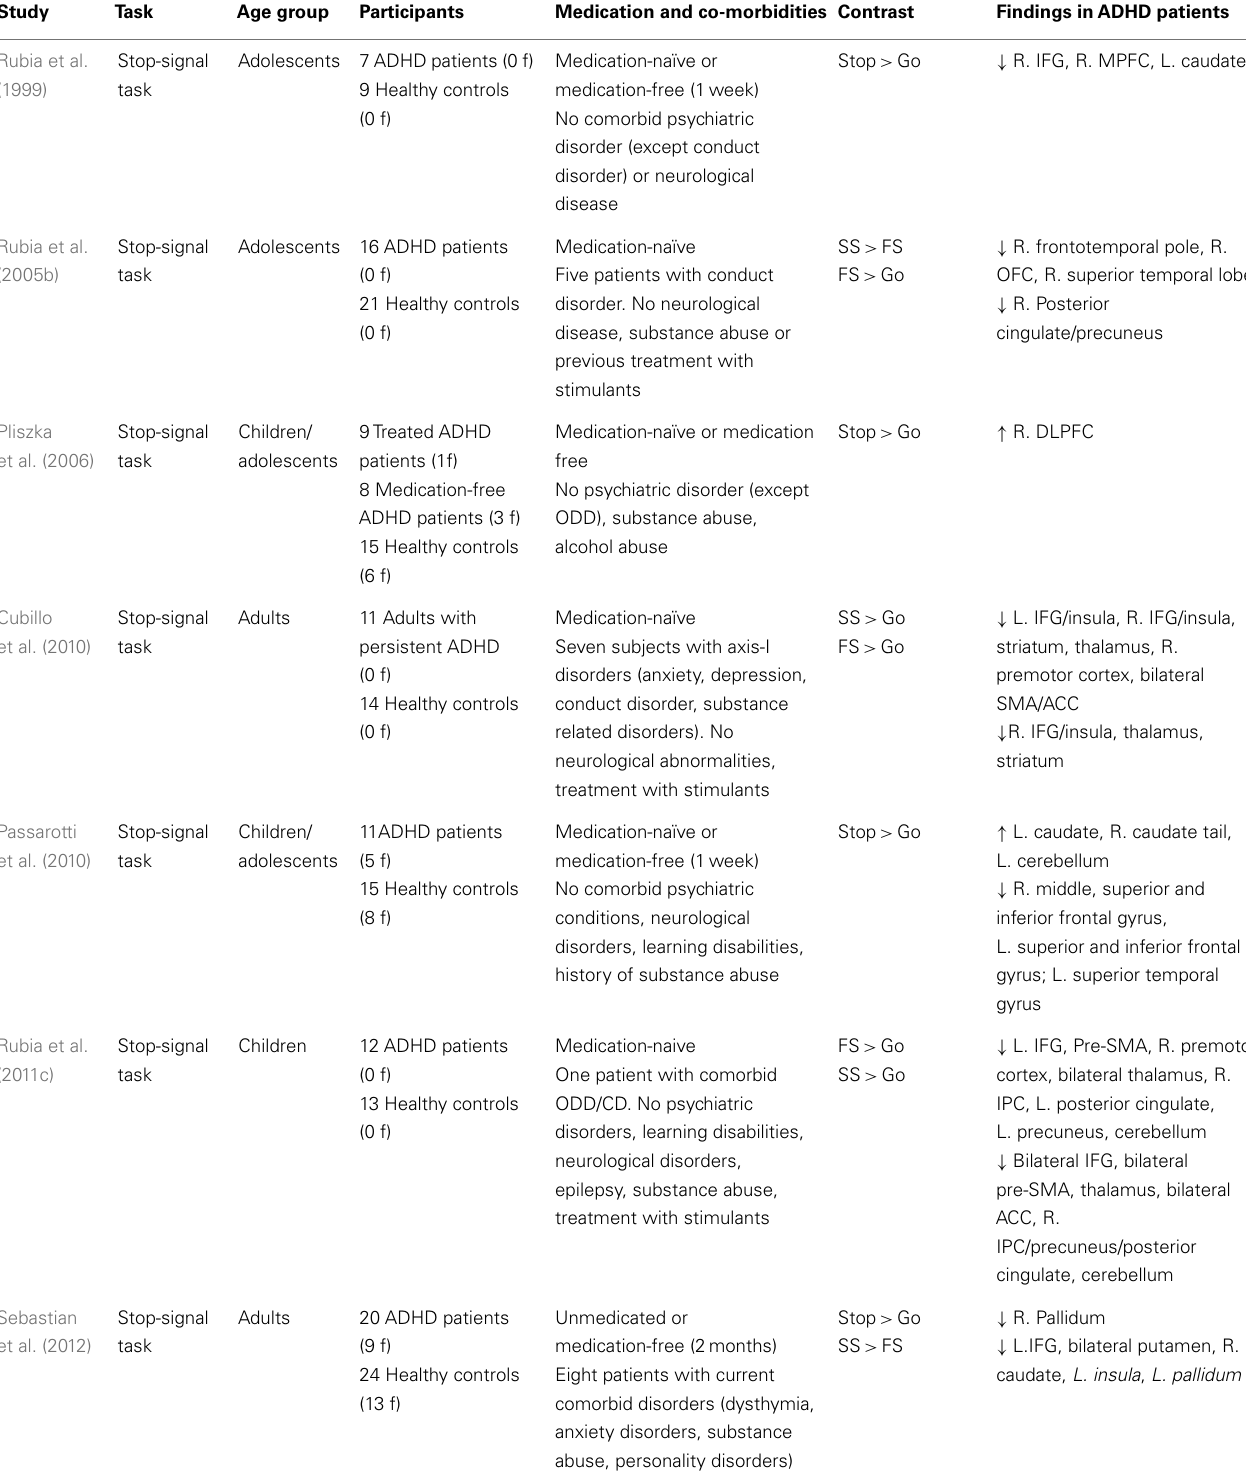
Table 5 | Overview of fMRI studies that have used response inhibition tasks in patients with attention-deficit hyperactivity disorder . Study